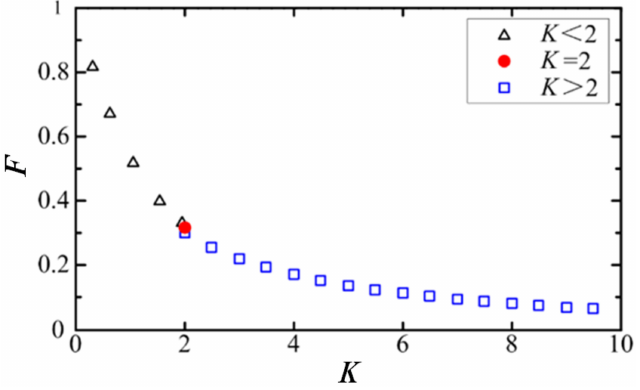
Figure 12. Schematic diagram of the magnetization principle of the magnetic